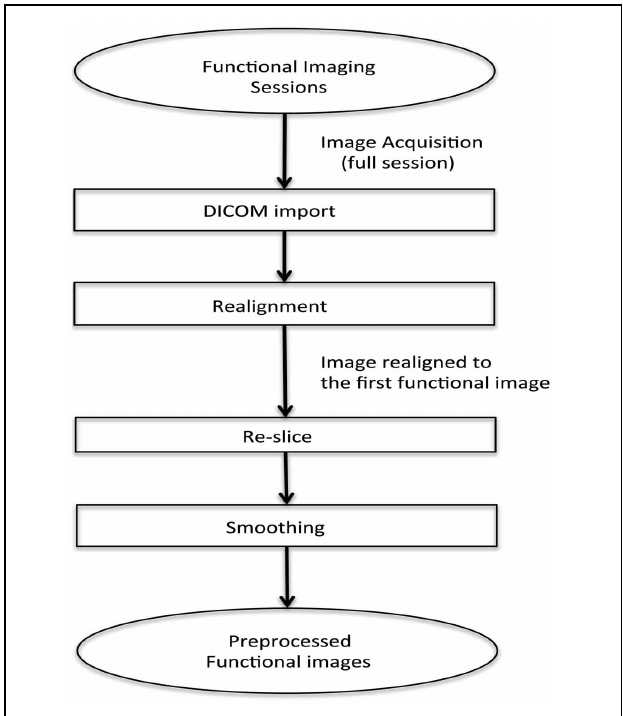
FIGURE 2 | Flowchart for pre-processing the functional images for online subject-dependent classifier. (1) DICOM images are converted to the ANALYZE format. (2) Transformation matrix for realignment is then calculated. (3) Re-slicing is performed using the matrix calculated in the previous step. (4) Smoothing of the data is performed.